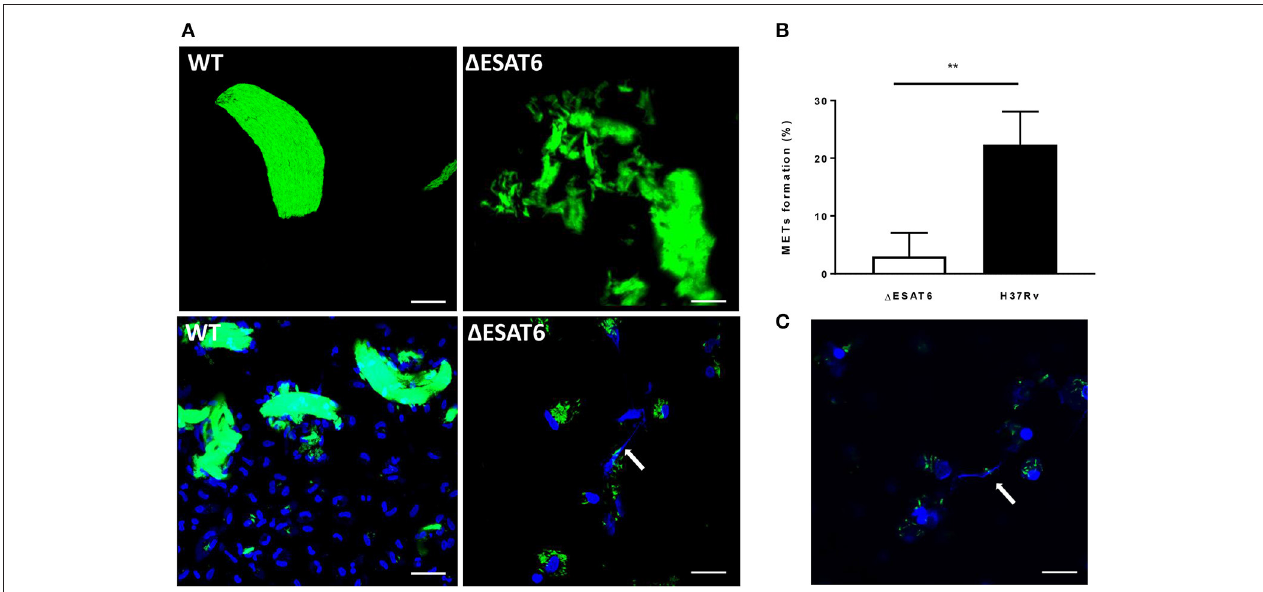
FIGURE 7 | ESAT-6 is required for MET formation. (A) 1 ESAT6 and the wild-type H37Rv strains were cultured on a shaker for 3 days with Tween low and used to infect hMDMs at MOI10. The cells were fixed after 24h and stained with DAPI to visualize DNA. Bar: 20 µ m. (B) The percentage of cells displaying METs formation